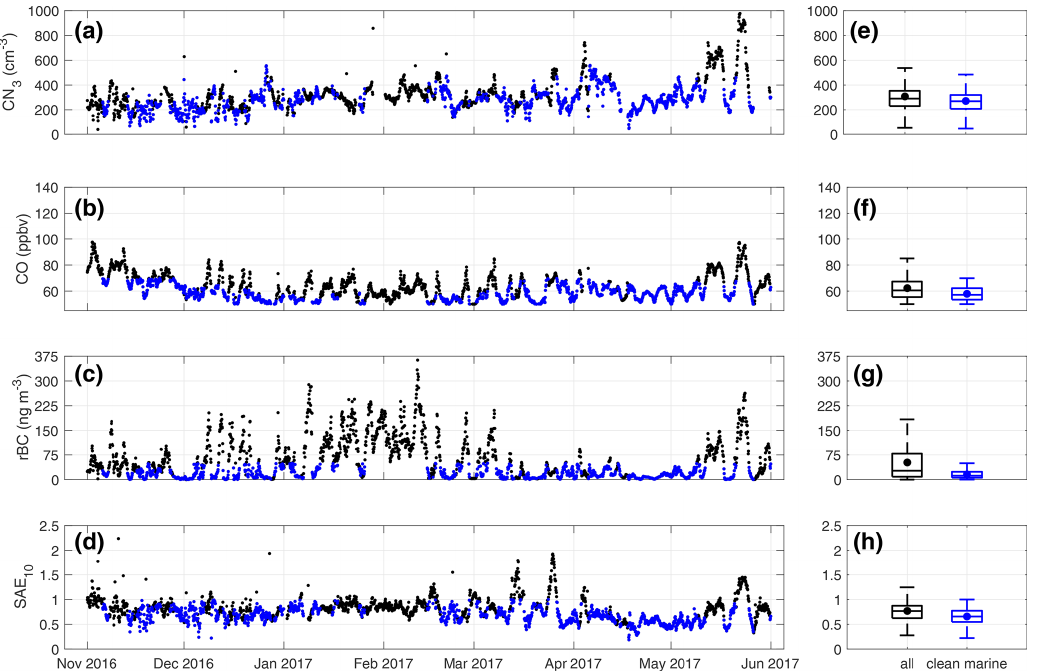
Figure 3. Time series (a–d) and box-and-whisker plots (e–h) of 2h average variables used to determine clean marine periods during the LASIC background season (November 2016–May 2017). (a–d) Periods that meet the criteria thresholds described in Sect. 2.2 are symbolized by blue dots. (e–h) Circles within the box-and-whisker plots are the means and horizontal lines are the medians and interquartile ranges (25% and 75%) for the background season (black) and clean marine periods